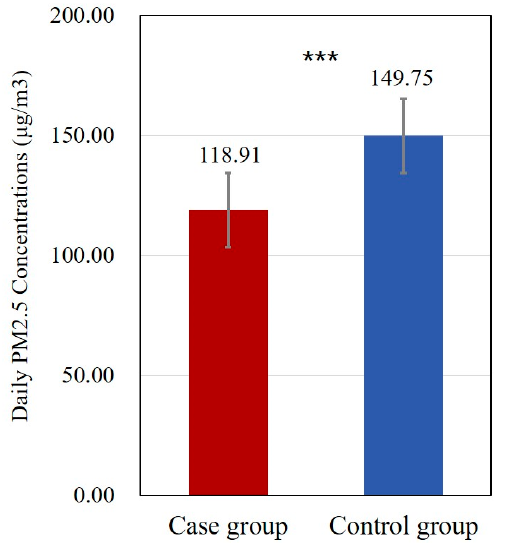
Figure 2. Daily mean PM 2.5 concentrations. *** p < 0.001.